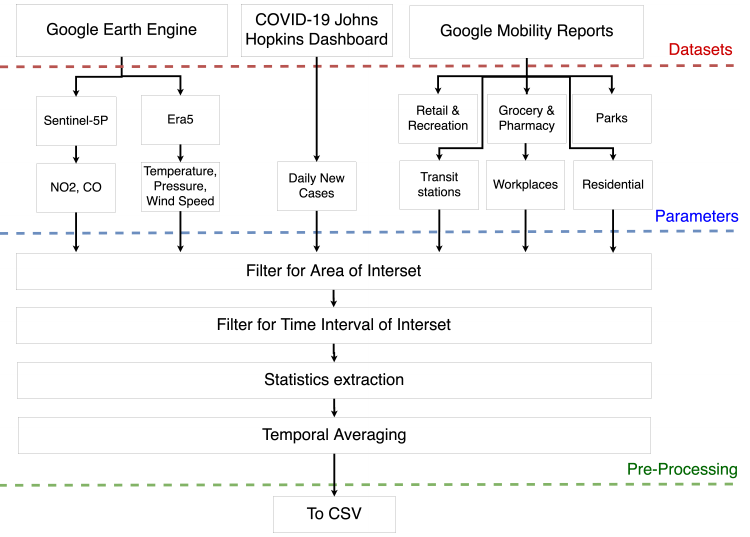
Figure 5. Data collection and processing scheme. The overall pipeline can be split into three main steps: source identification, data extraction and data pre-processing.